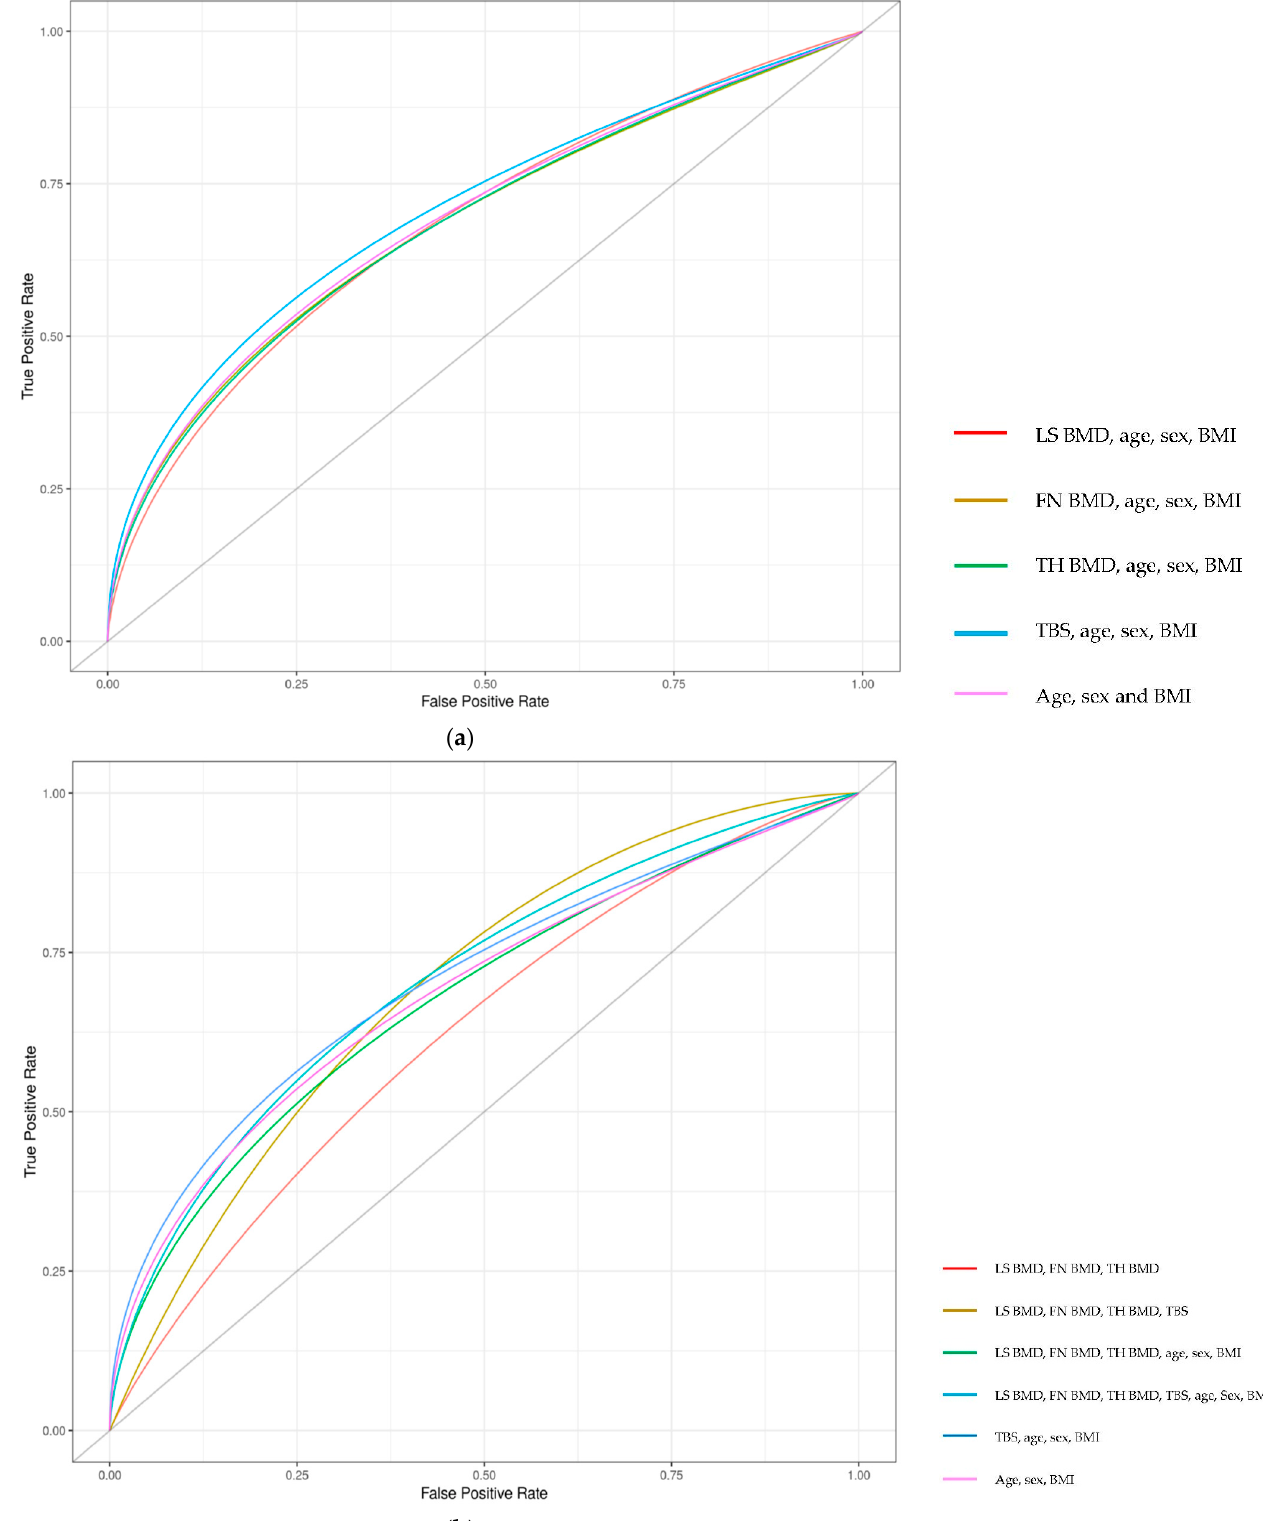
Figure 2. ROC for fracture prediction using BMD and TBS. ( a ): BMD of different regions and TBS for predicting fractures. ( b ): Combination of BMD regions with and without TBS for predicting fractures. LS: lumbar spine; BMD: bone mineral density; FN: femoral neck; TH: total hip; TBS: trabecular bone score; BMI: body mass